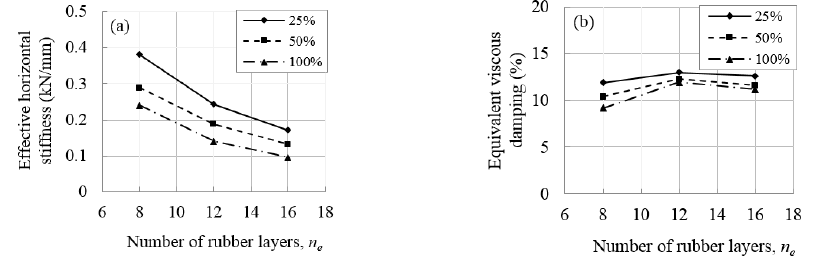
Figure 13. Effect of number of rubber layers on ( a ) effective horizontal stiffness and ( b ) equivalent viscous damping of C-FREIs at 25%, 50%, and 100% shear strains.